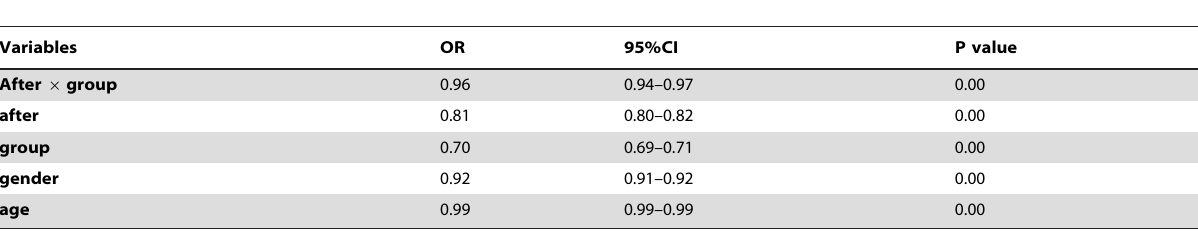
Table 4. Logistic regression results of injection